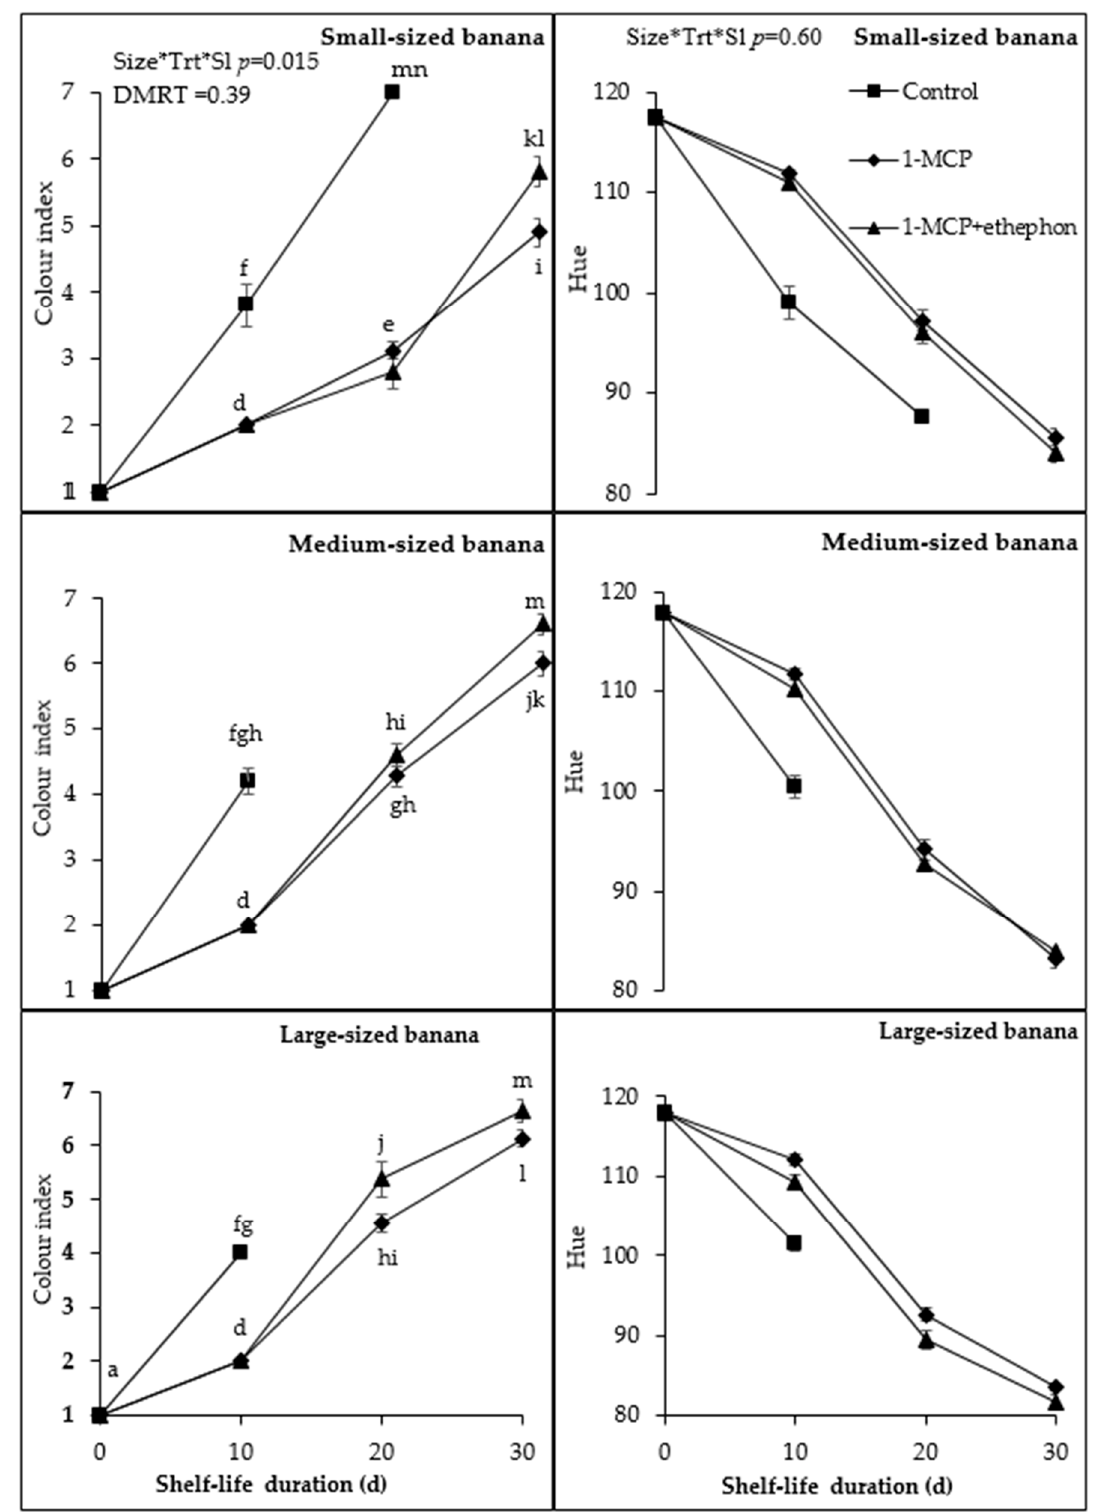
Figure 1. Effect of fruit size, 1-MCP treatments, and shelf-life and their interaction on peel colour index (left) and hue values (right) at ambient temperature. Size*Trt*Sl represents significant or non-significant interaction of fruit size, 1-MCP, and shelf-life duration at p < 0.05 or p > 0.05, respectively, according to Duncan Multiple Range Test (DMRT). Each value is a mean of four replicates ( n = 4) ± standard error. * Control fruit were removed at 15 d after they were fully yellow, indicating that they were fully ripe.